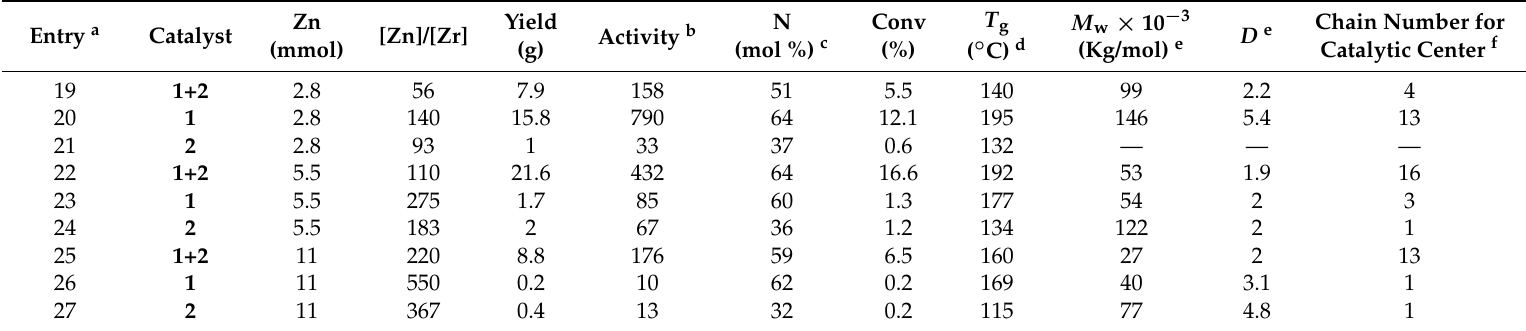
Table 3. Poly(Ethylene– co –Norbornene) using catalysts 1 and 2 in the presence of ZnEt 2 at [N]/[E] feed ratio of 26.0 and pE = 4